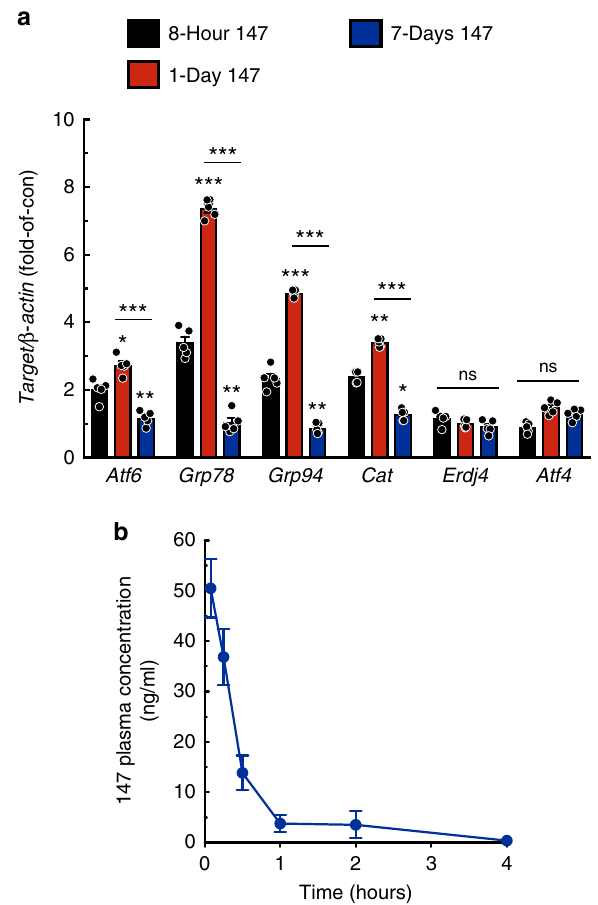
Fig. 5 147 acts transiently in vivo. a qPCR for Atf6 and ATF6 target genes Grp78 , Grp94 , and Cat in WT ( n = 5) mice either 8 hours, 1 day, or 7 days after a single bolus venous injection of 147 (2 mg/kg). b 147 plasma concentration as a function of time in mice receiving 2 mg/kg via venous injection. Blood was collected at baseline and 5min, 15min, 30min, 1h, 2h, and 4h post injection ( n = 4 mice per timepoint). Data are represented as mean ± s.e.m. Two-group comparisons were performed using Student ’ s two-tailed t test, and all multiple group comparisons were performed using a one-way ANOVA with a Newman – Keuls post hoc analysis. * P ≤ 0.05, ** P ≤ 0.01, and *** P ≤ 0.001; ns not signi fi